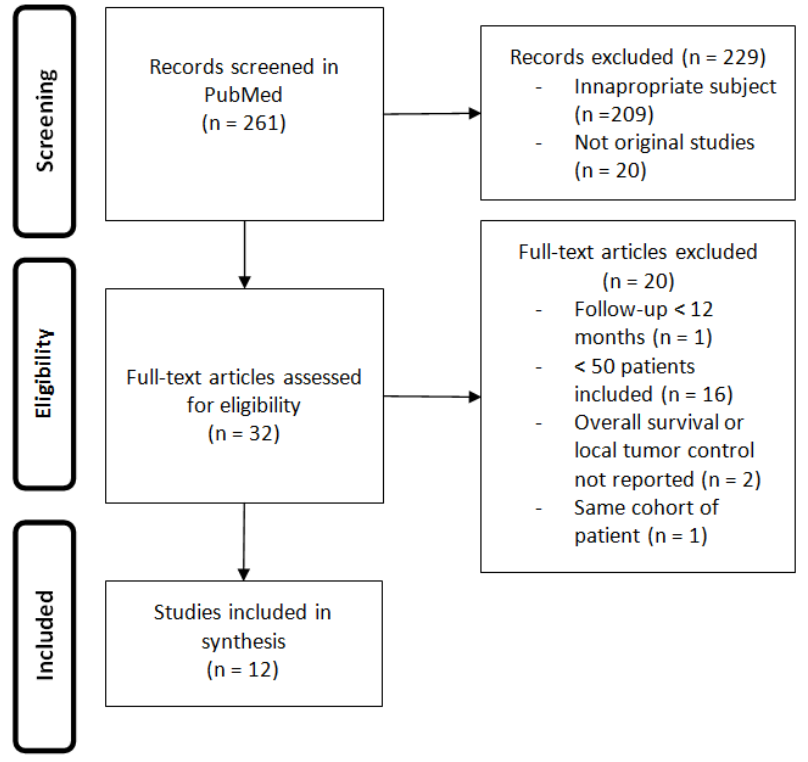
Figure 1. Consort diagram .